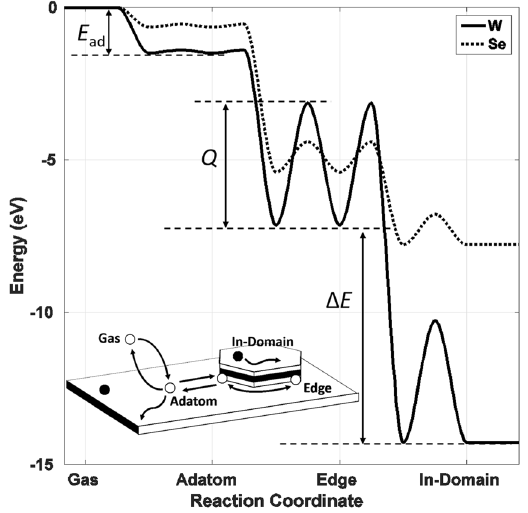
Figure 2. Simulated reaction energy diagram of the growth process. The simulation starts with adatoms; adatoms react with each other to form the TMD domains via free diffusion. After bonded into the domain, the in-flake atoms are mobile through edge diffusion and vacancy diffusion. Each state is defined by its state energy, calculated by the adsorption energy ( E ad ) and bond energy ( B . E .). Each process is defined by its transition activation energy ( Q or Q + Δ E ). The energy diagram is based on the DFT calculations presented in a previous publication 40